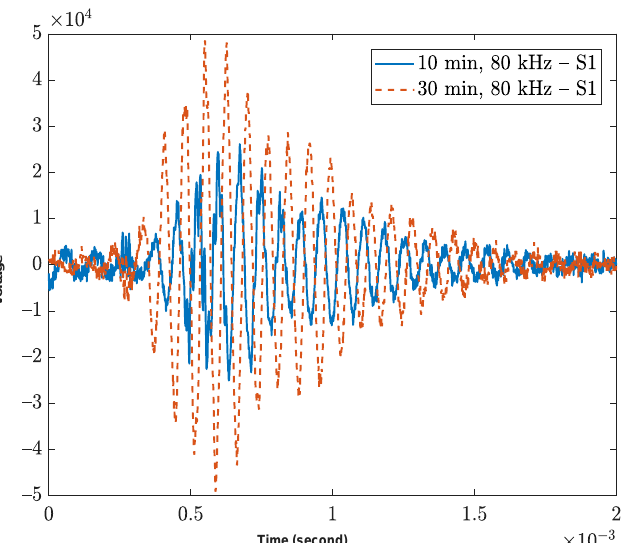
Figure 5. Comparison of wave speeds in concrete specimen during hardening process using different scanning times. The wave speed in the 30-min scanning data is faster than the 10-min data due to the ongoing hydration process of the concrete.